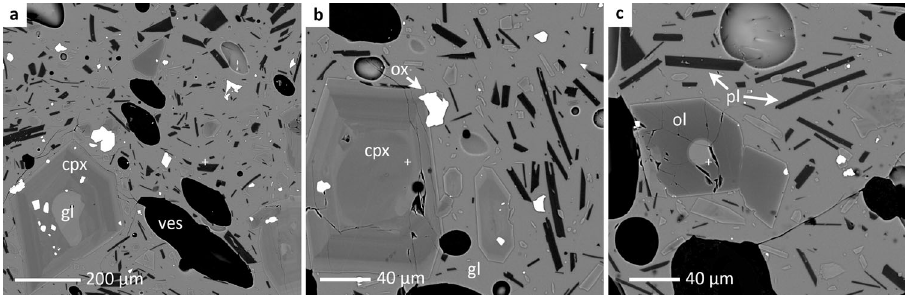
Fig. 5 Mineralogy and microtextures of Cumbre Vieja basanite ash. a – c Representative BSE photomicrographs of basanitic ash collected on 18 November, 2021. These images depict the dominant and widespread mineral assemblage occurring as microphenocrysts and microlites: clinopyroxene (cpx), olivine (ol), plagioclase (pl), and Fe – Ti oxides (titanomagnetite; ox). All silicate and oxide minerals were identi fi ed by EPMA analysis. Groundmass glass (gl) is abundant both in the matrix and as crystal-hosted inclusions (frames a and c ), and its composition varies subtly with the amount of microlites. Glass inclusions resemble the major element composition of the bulk rock (Fig. 4; Table 1). The compositions of coexisting clinopyroxene, plagioclase microlites, and glass in the assemblage indicates pre-eruptive P and T of ~7 – 10 kbar and 1150 – 1200 °C, respectively, in addition to relatively low melt-H 2 O contents (~0.8 wt.%; Supplementary Information).